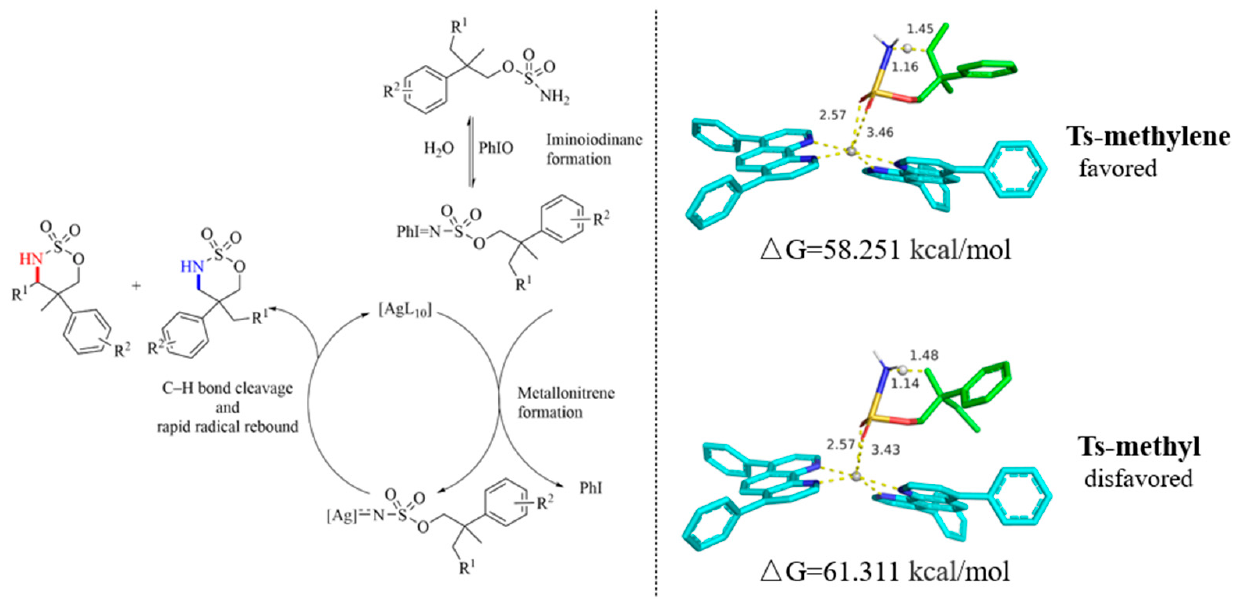
Figure 4. Proposed reaction pathway.